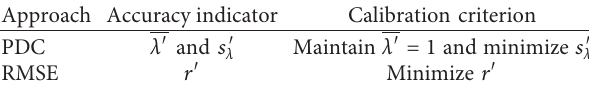
Table 1: Comparisons of the two model calibration